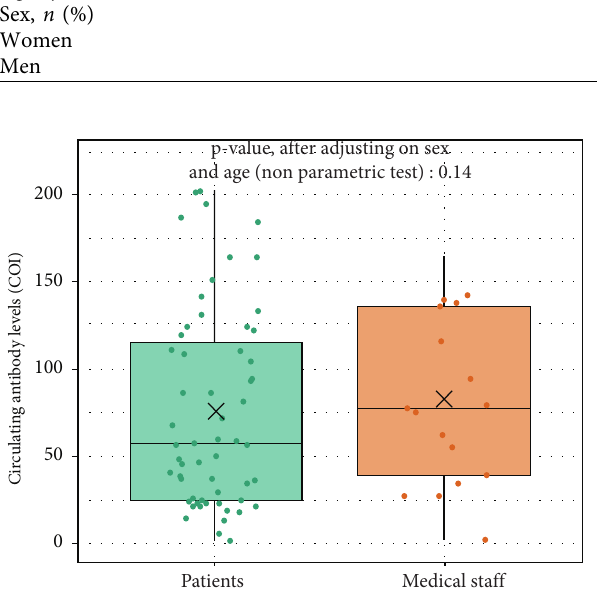
Figure 4: Comparison of the circulating levels of SARS-CoV-2 antibodies between the hemodialysis patients ( N � 57) and the control group of healthcare workers without kidney disease ( N �